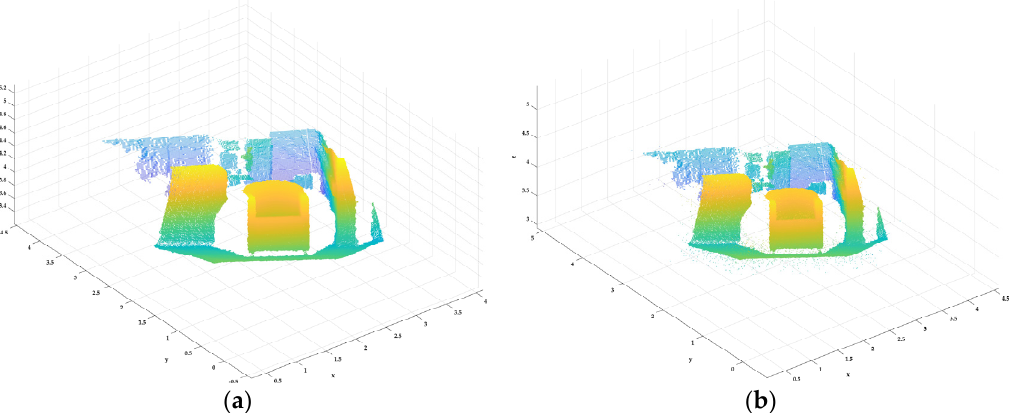
Figure 3. Effect of adding noise to the depth image. The point cloud image corresponding to the depth image ( a ) without and ( b ) with noise added.